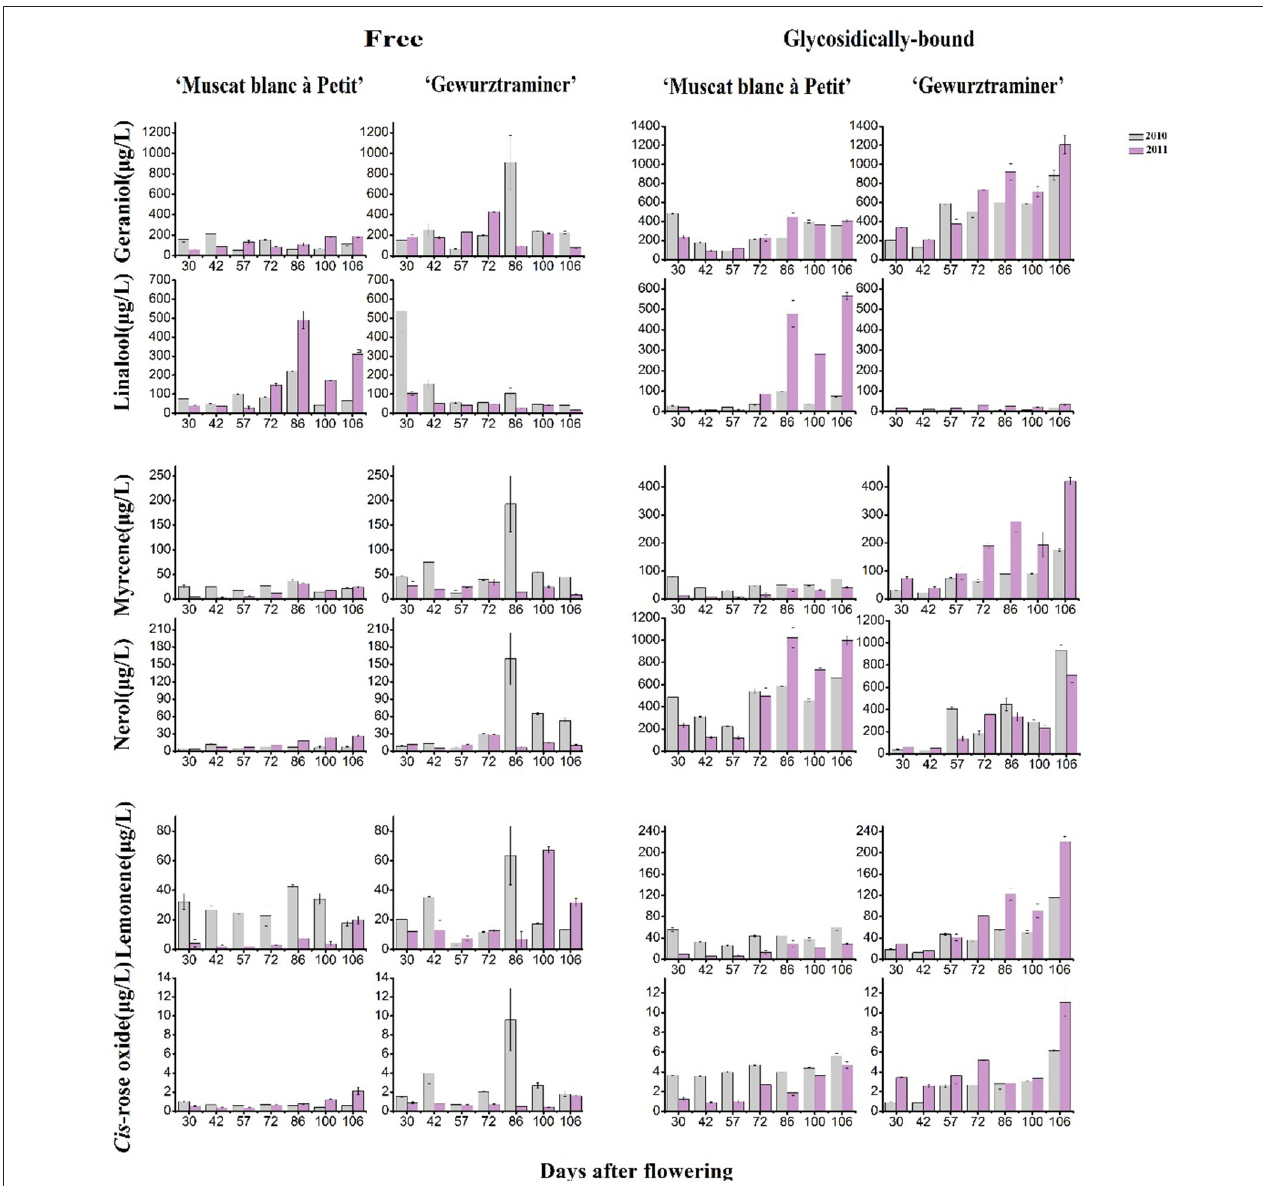
FIGURE 2 | Evolution of the concentrations of six main monoterpenes during berry development.